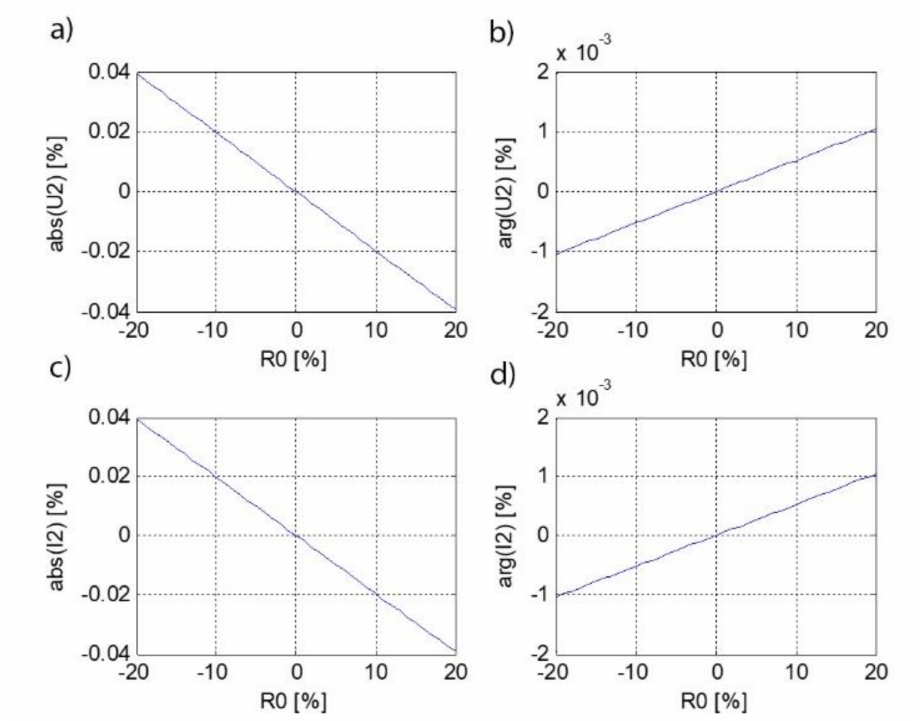
Figure 16. Changes of wave parameters depending on R 0 at f = 1 MHz; ( a ) U 2 voltage modulus, ( b ) U 2 argument, ( c ) I 2 modulus, ( d ) I 2